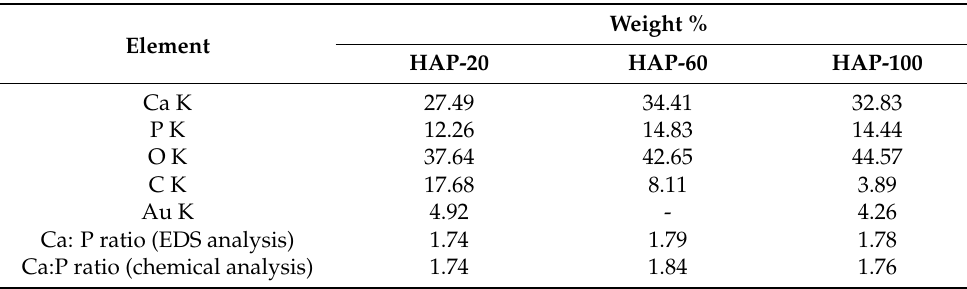
Table 5. Elemental compositions of HAp